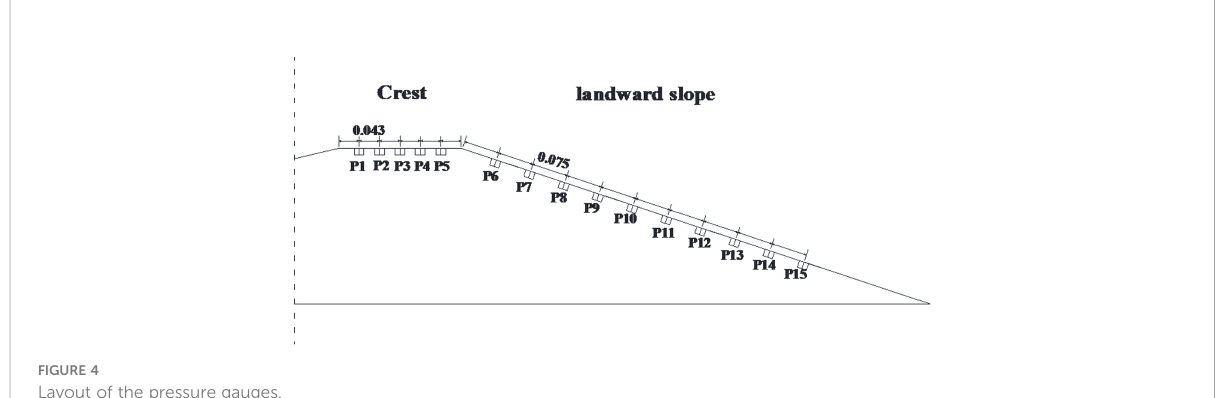
FIGURE 4 Layout of the pressure